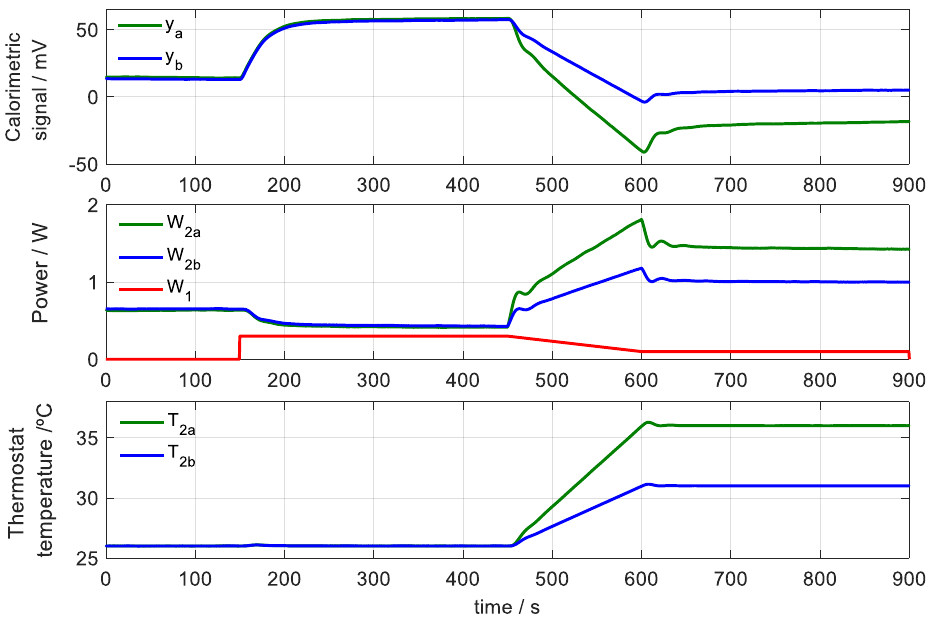
Figure 3. Experimental calibration measurements. Power dissipated in the base ( W 1 ), power dissipated in the thermostat ( W 2a and W 2b ), calorimetric signal ( y a and y b ) and temperature of the thermostat ( T 2a and T 2b ). The green curves represent the case of an increase of 10 K in temperature of the thermostat (from 26 to 36 ºC), and the blue curves an increase of 5 K (from 26 to 31 ºC). T room = 23.4 ºC. A minimization method based on the Nelder–Mead simplex algorithm [33–35] is used to identify the model parameters. The error criterion used is the sum of the roots of the root mean square errors (RMSE), weighted (Equation (7)). The root mean square error is calculated with the experimental curves (subscript exp ) and those calculated by the model (subscript cal ).